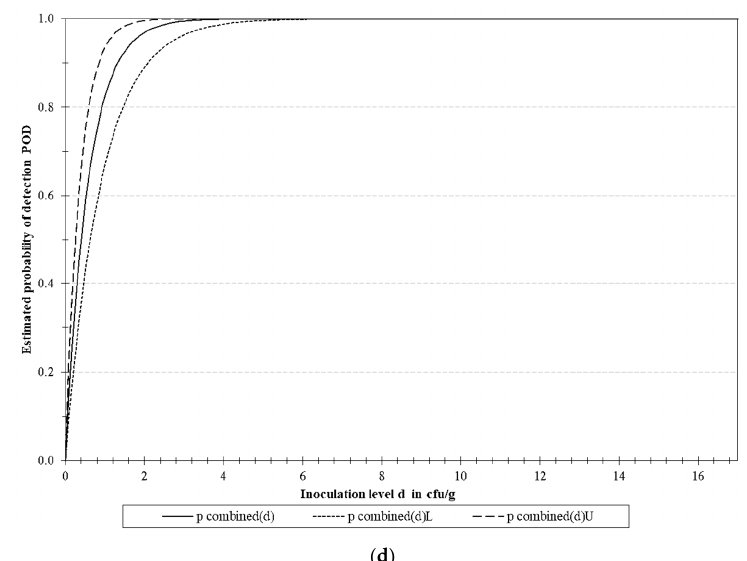
Figure 4. Graphical representation of the estimated probability of detection (POD) for E. coli O157 ( a ), Salmonella spp. ( b ), L. monocytogenes ( c ) and the combined detection of the three pathogens at the same time ( d ). Six samples inoculated with 5 different contamination levels were used for POD evaluation. The bacteria concentration used were 16.6, 10.2, 5.1, 2.3 and 2.2 CFU/25 g for L. monocytogenes , 7.4, 5.5, 2.8, 1.1 and 0.9 CFU/25 g for Salmonella spp. and 5.5, 5, 2.5, 0.8 and 0.2 CFU/25 g for E. coli O157. “ p